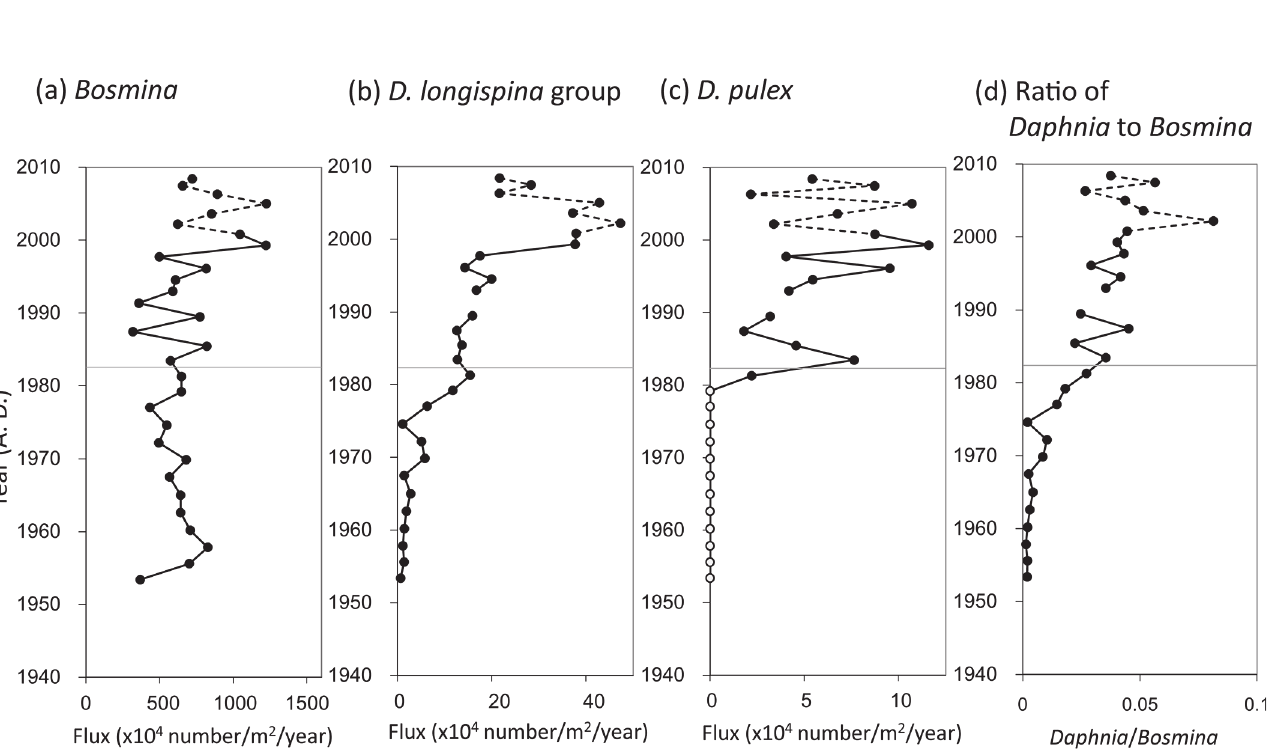
Fig 5. Fluxes of protozoan zooplankton remains. Fluxes of inaccurately estimated chronological years are denoted by broken lines. Two distinct periods (I and II) from the cluster analysis in Fig. 4 are divided by a thin line.